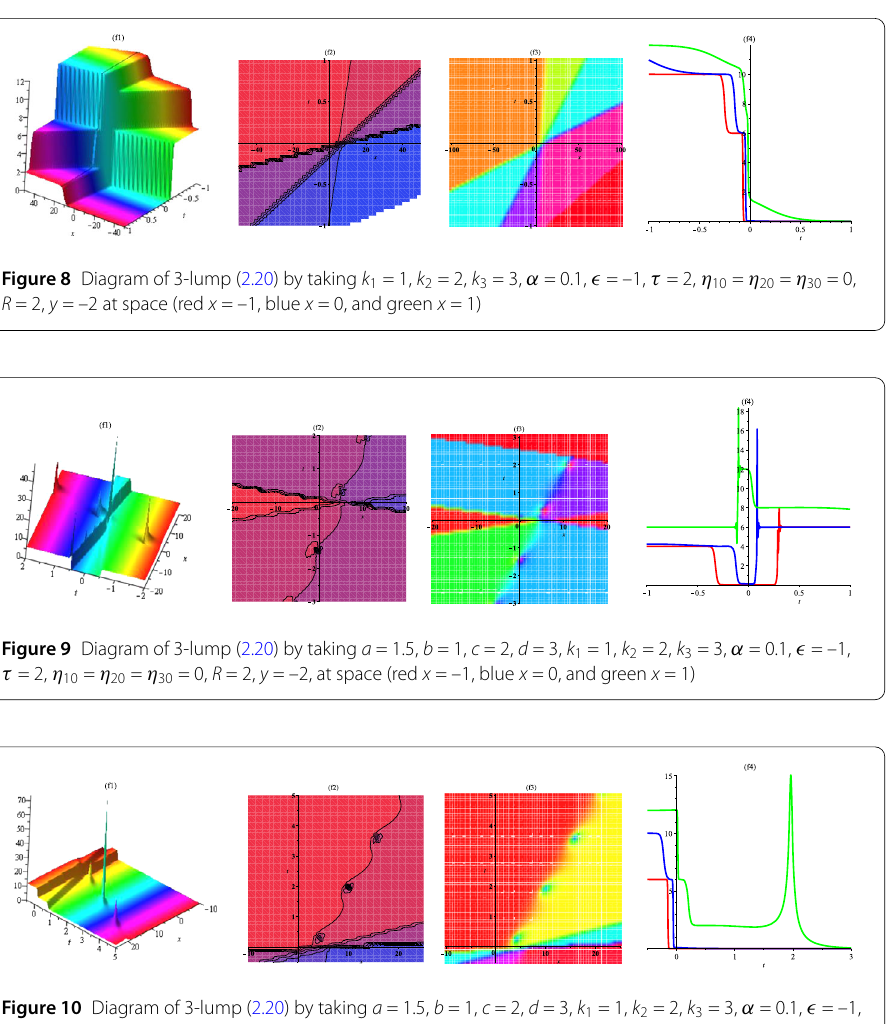
3 Interaction between lumps and stripe solitons of equation